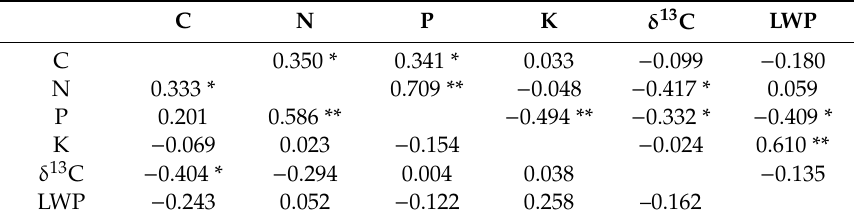
Table 5. Phylogenetically independent contrast (PIC) correlations (above the diagonal) and Pearson’s correlation (below the diagonal) for the di ff erent leaf traits at the species